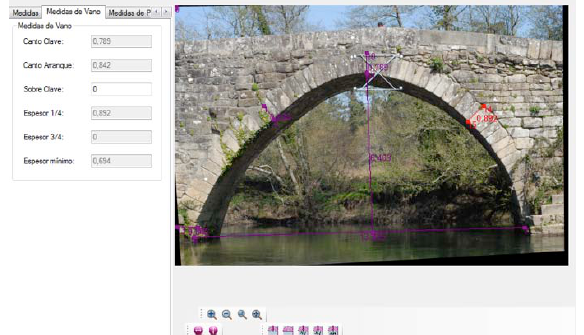
Figure 5. Rectified image of an arch with application for metric inventory.